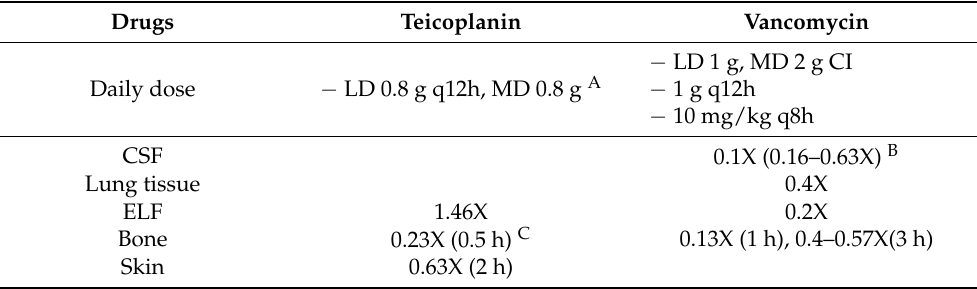
Table 2. Tissue penetration of